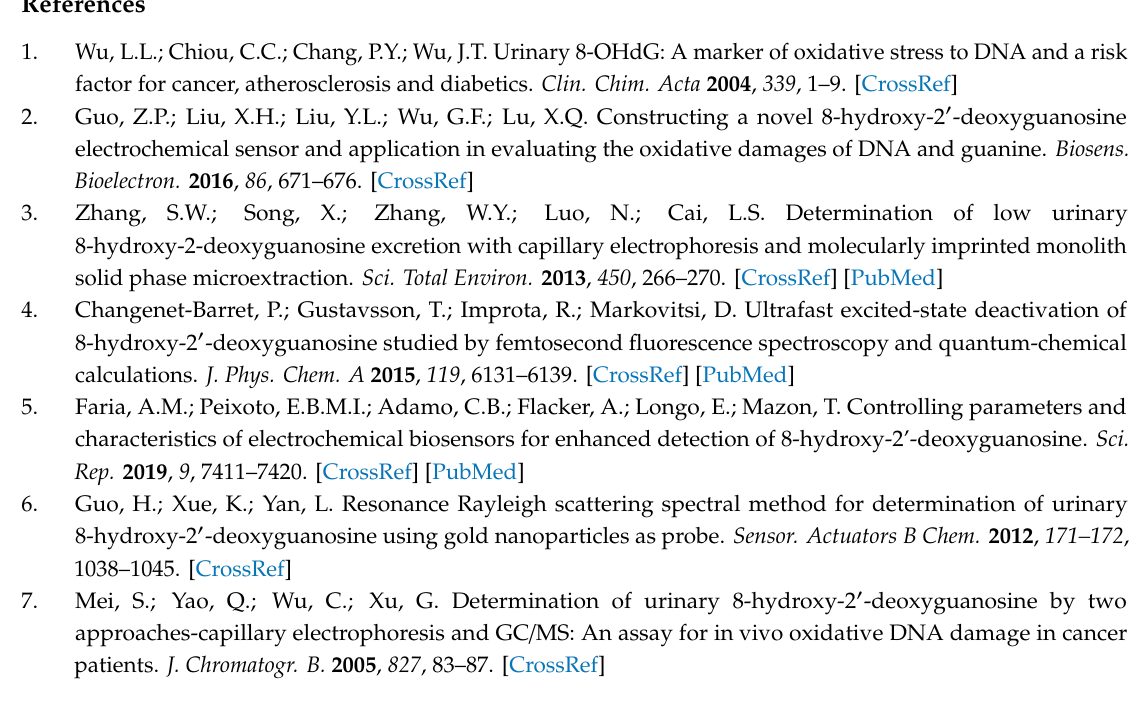
Figure S1: XRD pattern of Au@ZIF-8 nanoparticles; Figure S2: FTIR spectrum of Au@ZIF-8 nanoparticles; Figure S3: Energy dispersive X-ray spectroscopy (EDX) result for the carbon dots (CDs)-modified nanoporous alumina membranes with 8-OHdG capture and Au@ZIF-8 nanoparticles attachment; Figure S4: The excitation spectrum and emission spectrum of CDs. Inset: photoluminescence of CDs in solution; Figure S5: Photoluminescence spectra of CDs with pH 2 increased to pH 10. Inset: photoluminescence of CDs with pH 7 (right) and pH 8 (left); Figure S6. The variations of NaCl, KCl, CaCl 2 , MgCl 2 , thymine, cytosine, guanine, and adenine